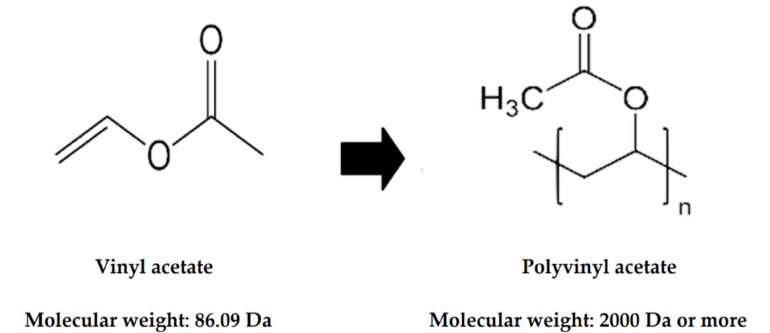
Figure 1. Structures of vinyl acetate and polyvinyl